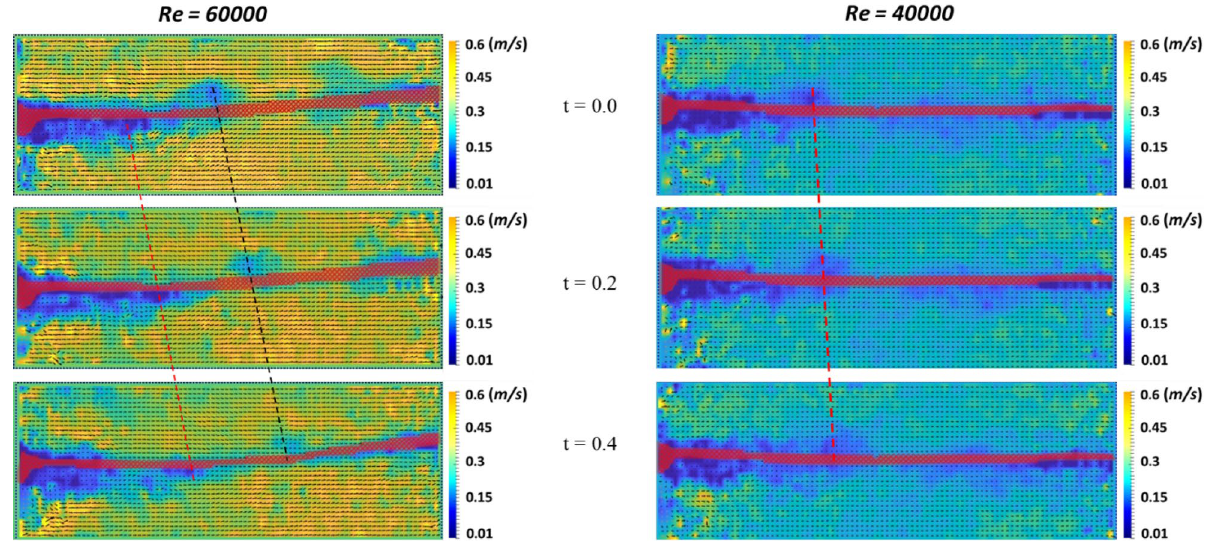
Figure 3. Instantaneous vortex contours and velocity vectors at Re = 60,000 and 4000, and t = 0, 0.2, 0.4.